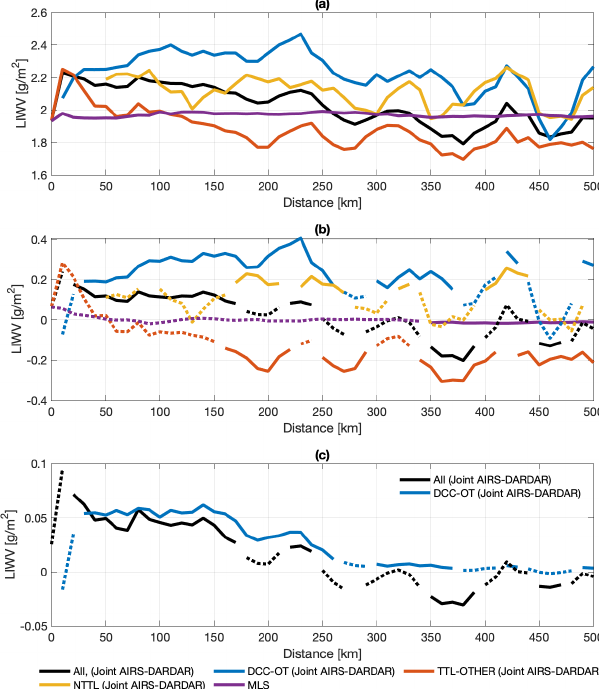
Figure 10. (a) Layer integrated water vapor (LIWV) above 16km from the joint AIRS–DARDAR retrieval (black) and MLS (pur- ple). Samples retrieved by the synergistic retrieval are separated into overshooting TTL clouds (DCC-OT, blue), other non-overshooting TTL clouds (orange), and non-TTL clouds (yellow). Solid curves show the statistically significant (99% confidence level) anomalies, while dashed curves are not statistically significant at the 99% level. (b) The same as (a) except for the anomaly in LIWV. (c) Contribu- tions to the LIWV anomaly from thick upper tropospheric clouds (BT 1231 < 230K, black) and DCC-OT clouds